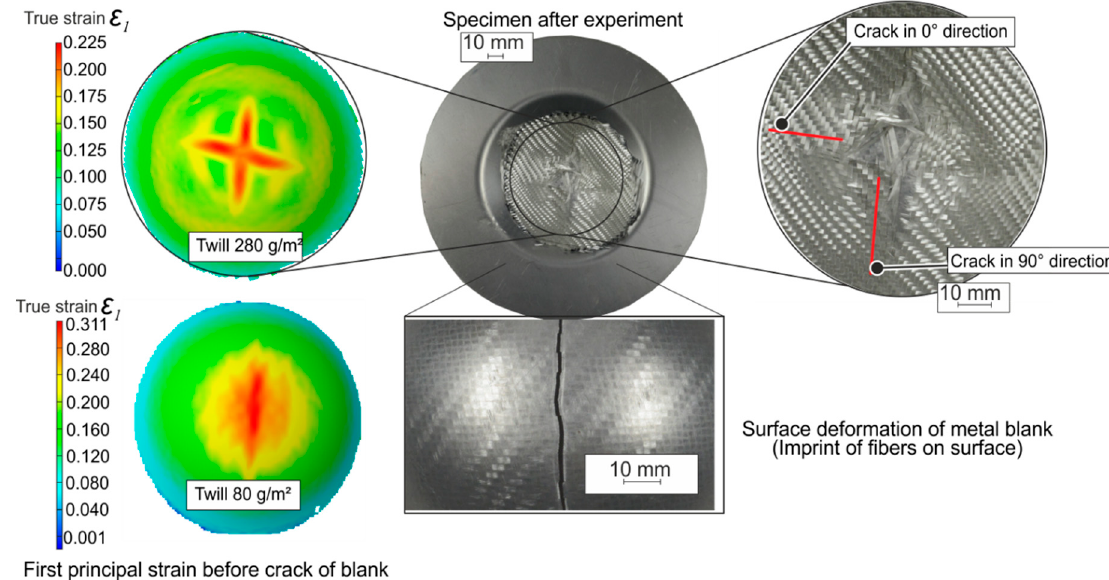
Figure 6. Comparison of strain distribution and fiber (Twill 280 g/m 2 ) fracture in Nakazima test specimen.